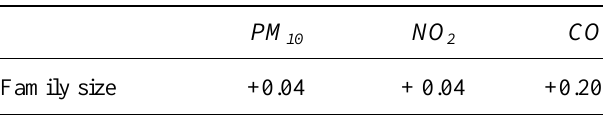
Table 7: Pearson correlation coefficients (R)